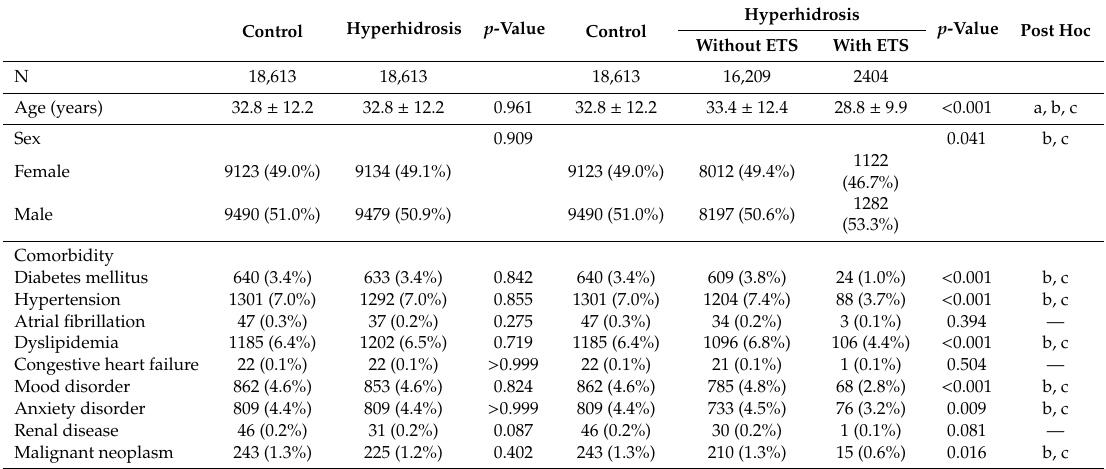
Table 1. Baseline characteristics of the study subjects according to the presence or absence of hyperhidrosis and ETS status. Control Hyperhidrosis p -Value Control